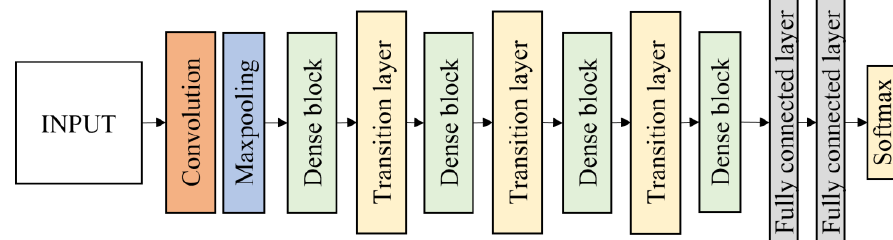
Figure 8. Single dense block. Figure 9. Fine-tuned DenseNet121 and DenseNet201 architecture. Figure 9. Fine-tuned DenseNet121 and DenseNet201